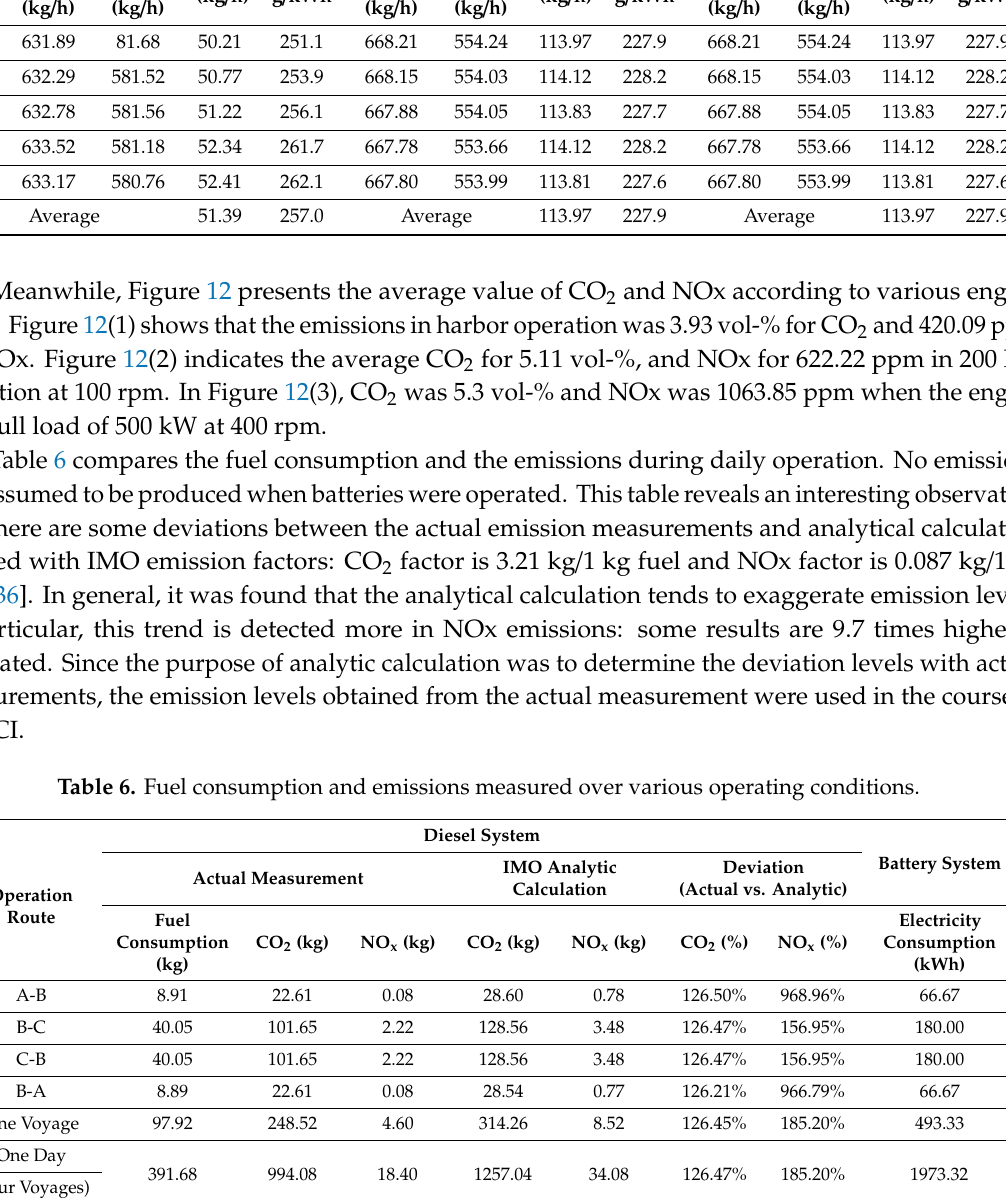
Table 5. Results of fuel consumption measurements.